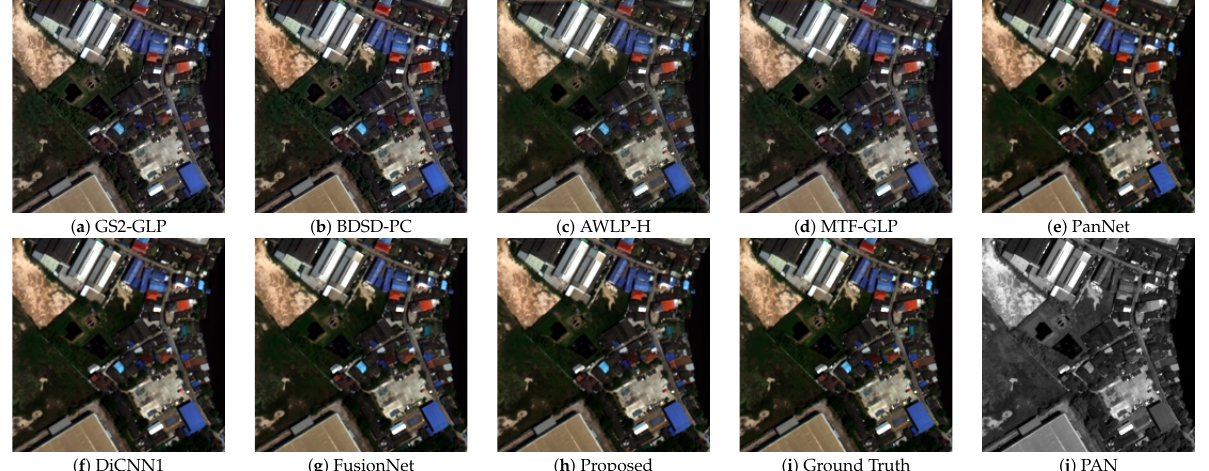
Figure 6. Fusion results of a group of reduced-resolution samples on the WorldView-3